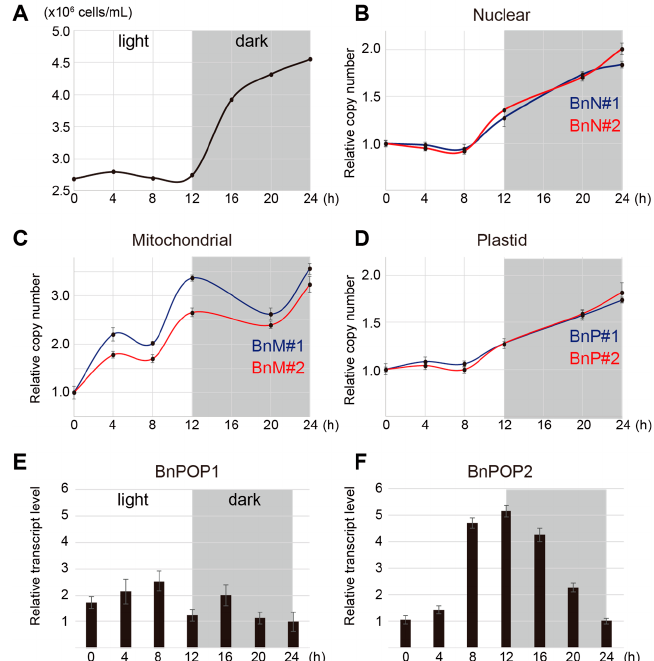
Figure 3. Timings of DNA replication for nuclear, mitochondrial, and plastid genomes. ( A ) Cell growth in temporally synchronized culture of Bigelowiella natans during a diurnal cycle. ( B – D ) Plots of changes in nuclear, mitochondrial, and plastid DNA levels, which were determined by real-time qPCR with two sets of specific primers (blue and red). ( E , F ) Relative transcript levels for BnPOP1 and BnPOP2. Error bars represent the standard deviation of triplicate qPCR reactions.